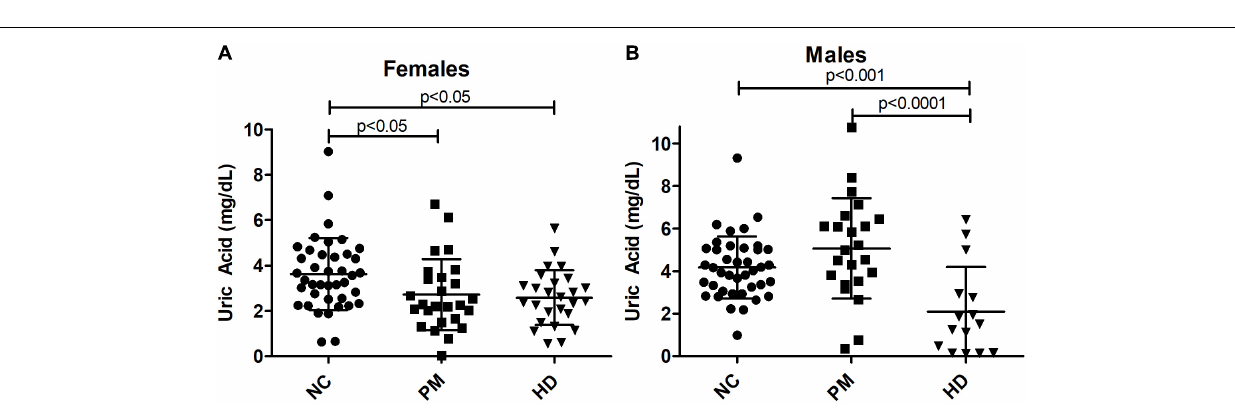
FIGURE 4 | Alterations in salivary uric acid (UA) levels according to diagnostic group in females (A) and males (B) . Uric acid levels are shown according to diagnostic group, premanifest [pre-Huntington’s disease (PM), manifest HD (HD), and normal controls (NC). Significant differences among diagnostic groups were determined using one-way ANOVA, followed by Bonferroni posttest to compare all groups: p < 0.05, p < 0.001, p < 0.0001, as shown. Bars reflect the mean uric acid levels ± SD.